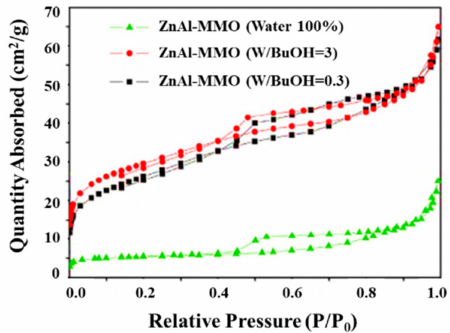
Figure 6. N 2 adsorption-desorption isotherms of ZnAl-MMO with water, water/BuOH = 0.3 and 3 (adapted from [70] with permission from Elsevier,